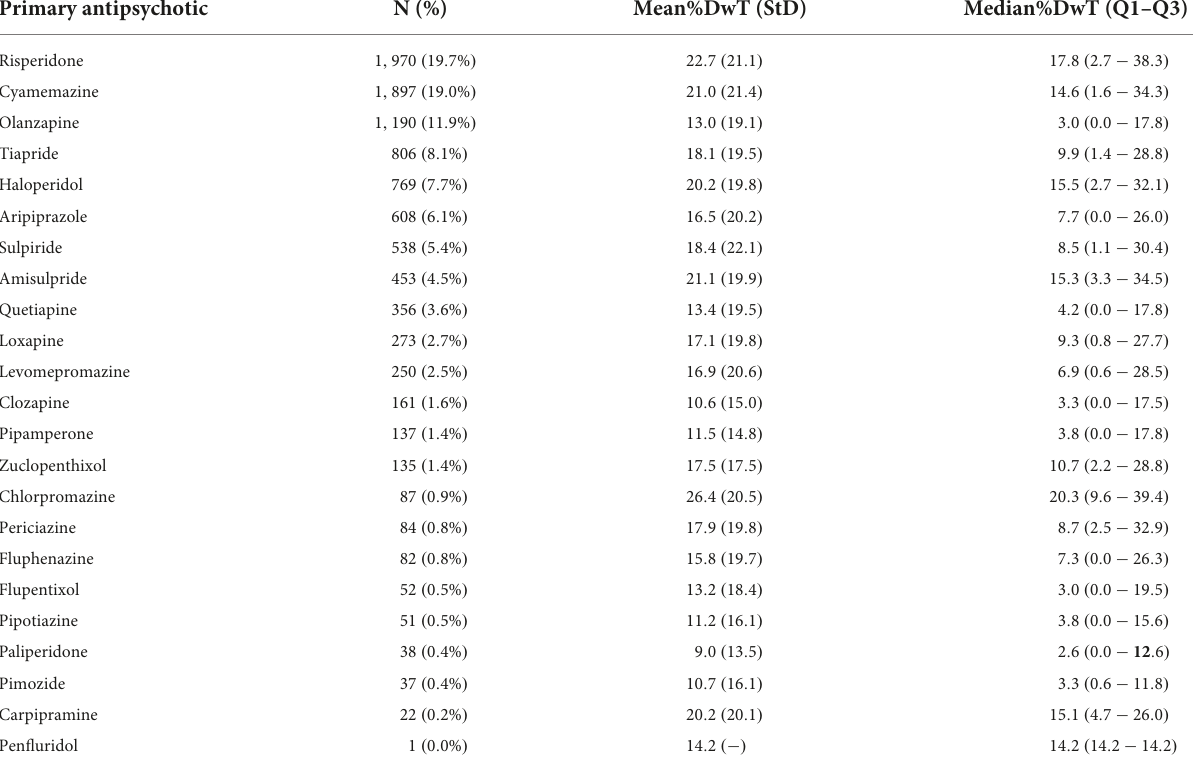
TABLE 4 Proportion of days without treatment (%DwT) of each primary antipsychotic over the 12 months after inclusion, among patients with at least 12 months of dispensing ( n = 9,997). Primary